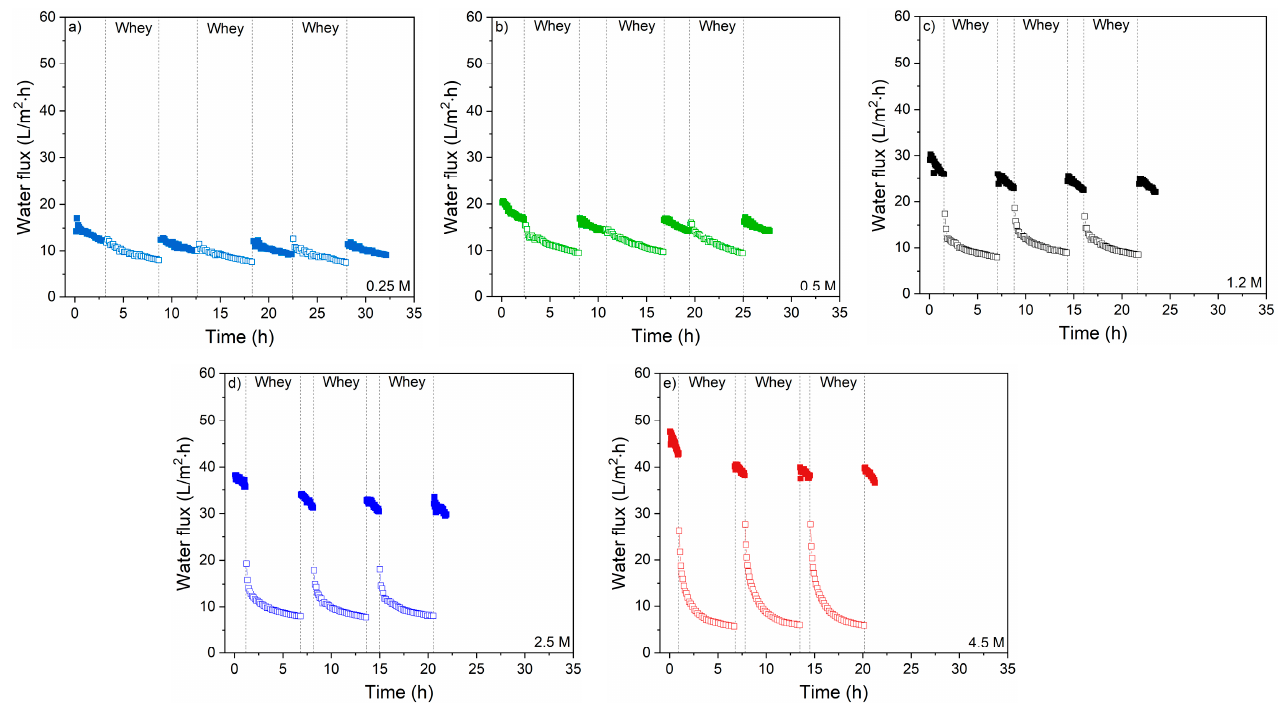
Figure 9. Water flux of the membranes in longer periods of whey filtration (three times, in total ~17 h) with intermediate